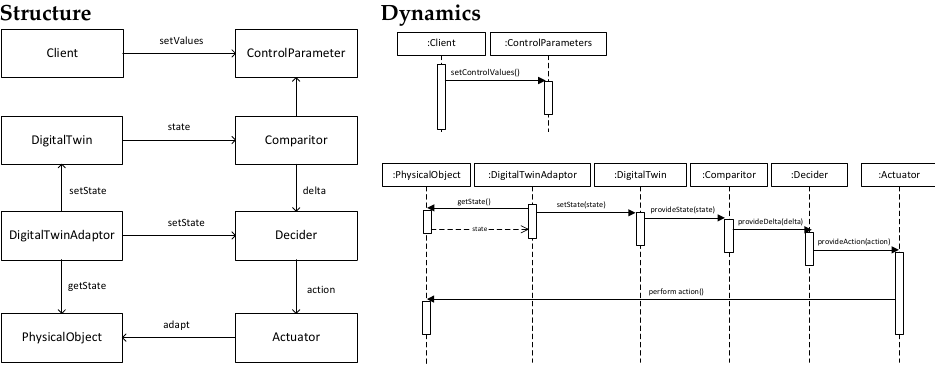
Figure 14. Digital Control